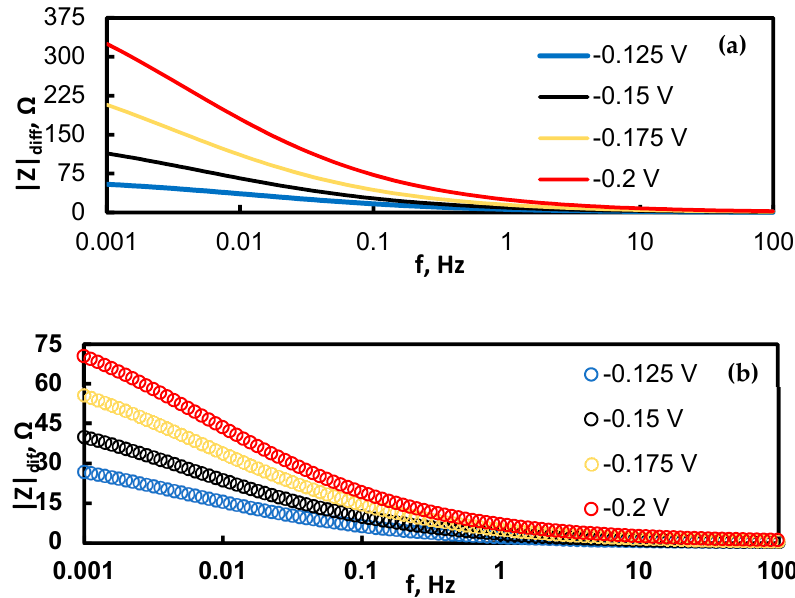
Figure 7. Bode plots of extracted diffusion impedance at various potentials on flat Cu substrate ( a ); and Cu foam substrate ( b ).